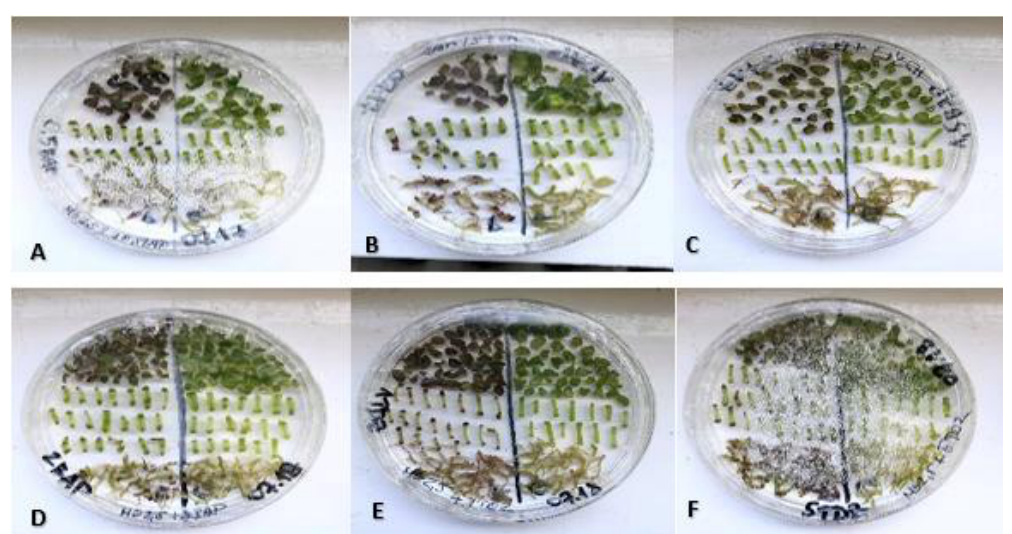
Figure 2. Explants on media containing different hormones.